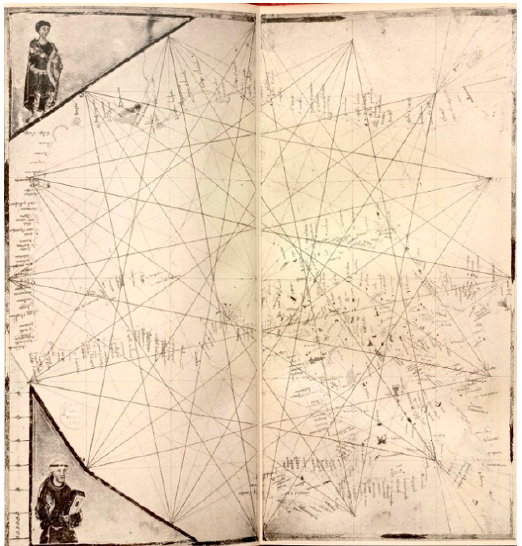
Figure 3. St George and St Francis in the Atlas-Portolano of Petrus Vesconte, Venice, 1319. Lyon, Ms. 175. F. 7–8. Source: (De LaRoncière 1929, Table IV).